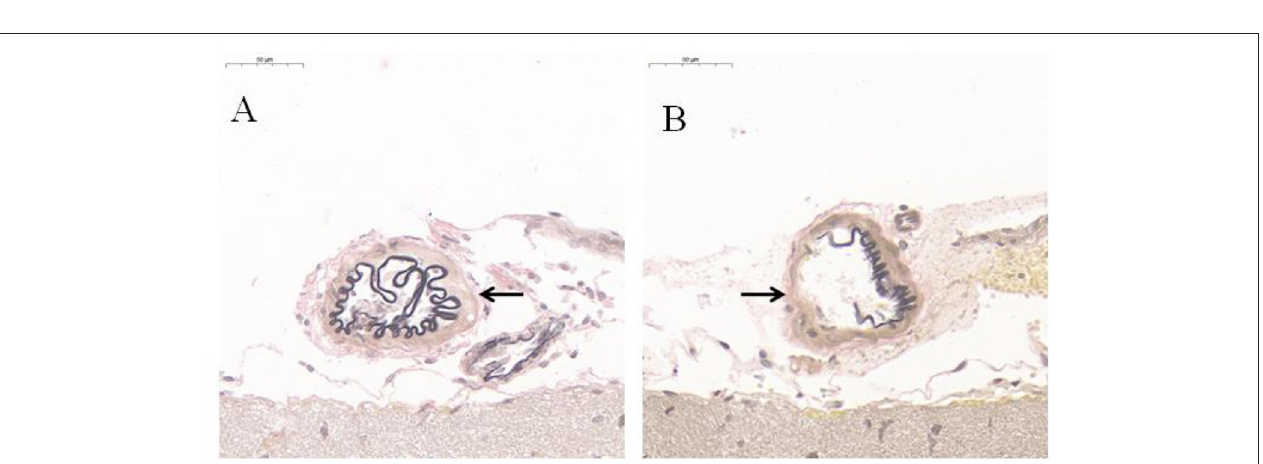
FIGURE 4 | EVG histological staining of communicating artery vessels ( n = 5). (A) Control group; (B) Experimental group. After modeling, the internal elastic lamina of the tunica media of the communicating artery was disrupted black arrow; the muscular layer was atrophied, and the connective tissue was hyalinized. However, no significant change was observed in the Control group black